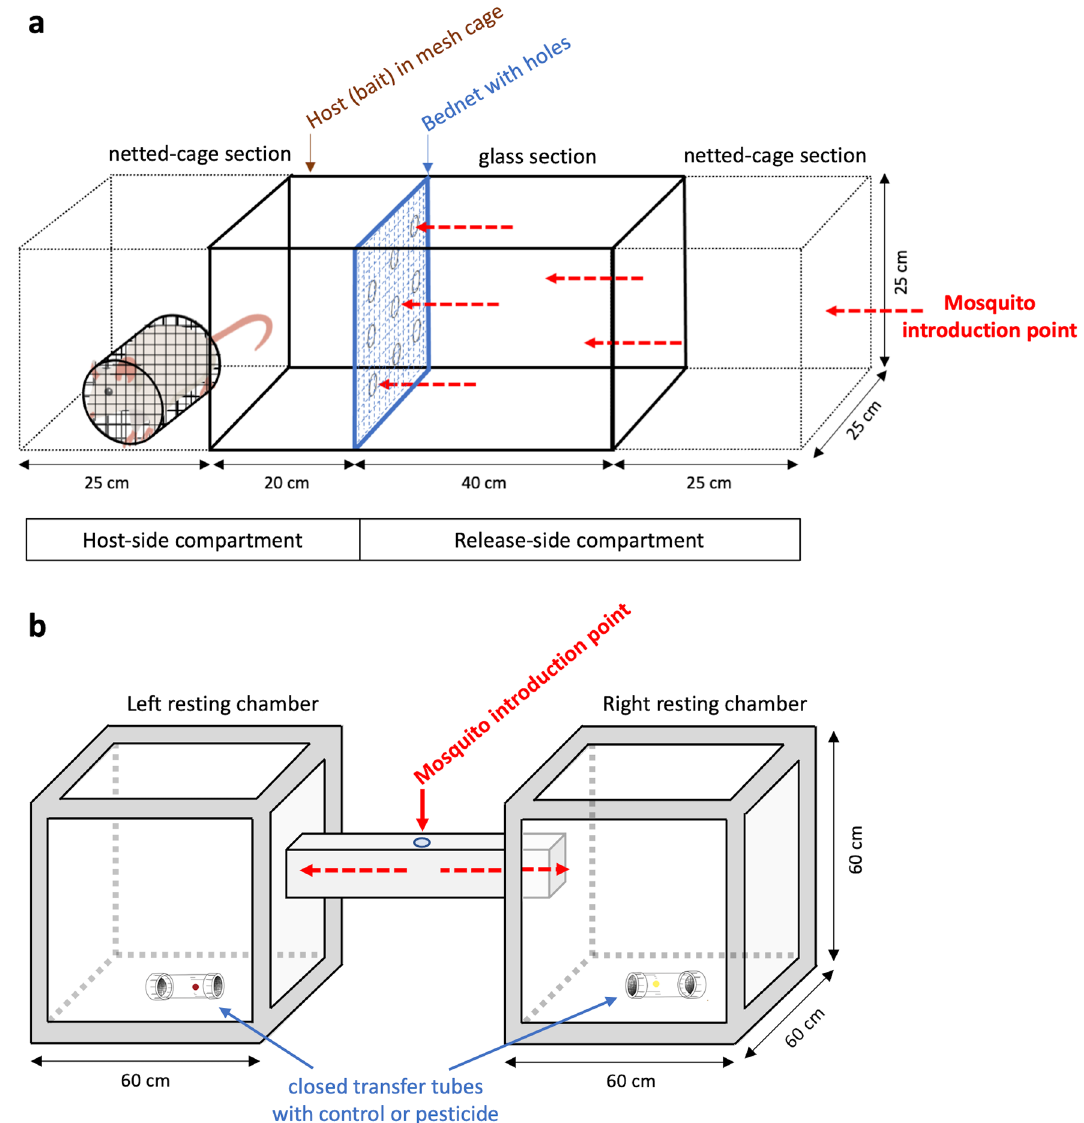
compartments linked by a bridge to measure the level of